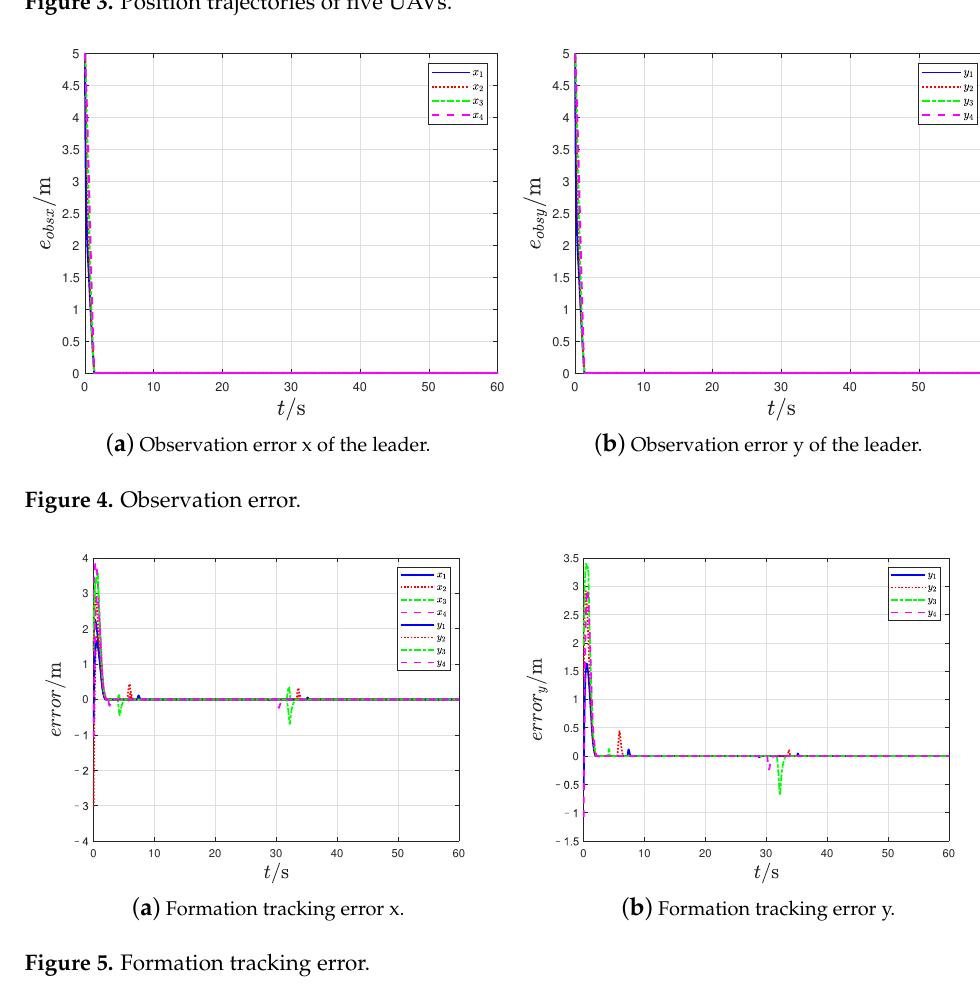
Figure 3. Position trajectories of five UAVs.